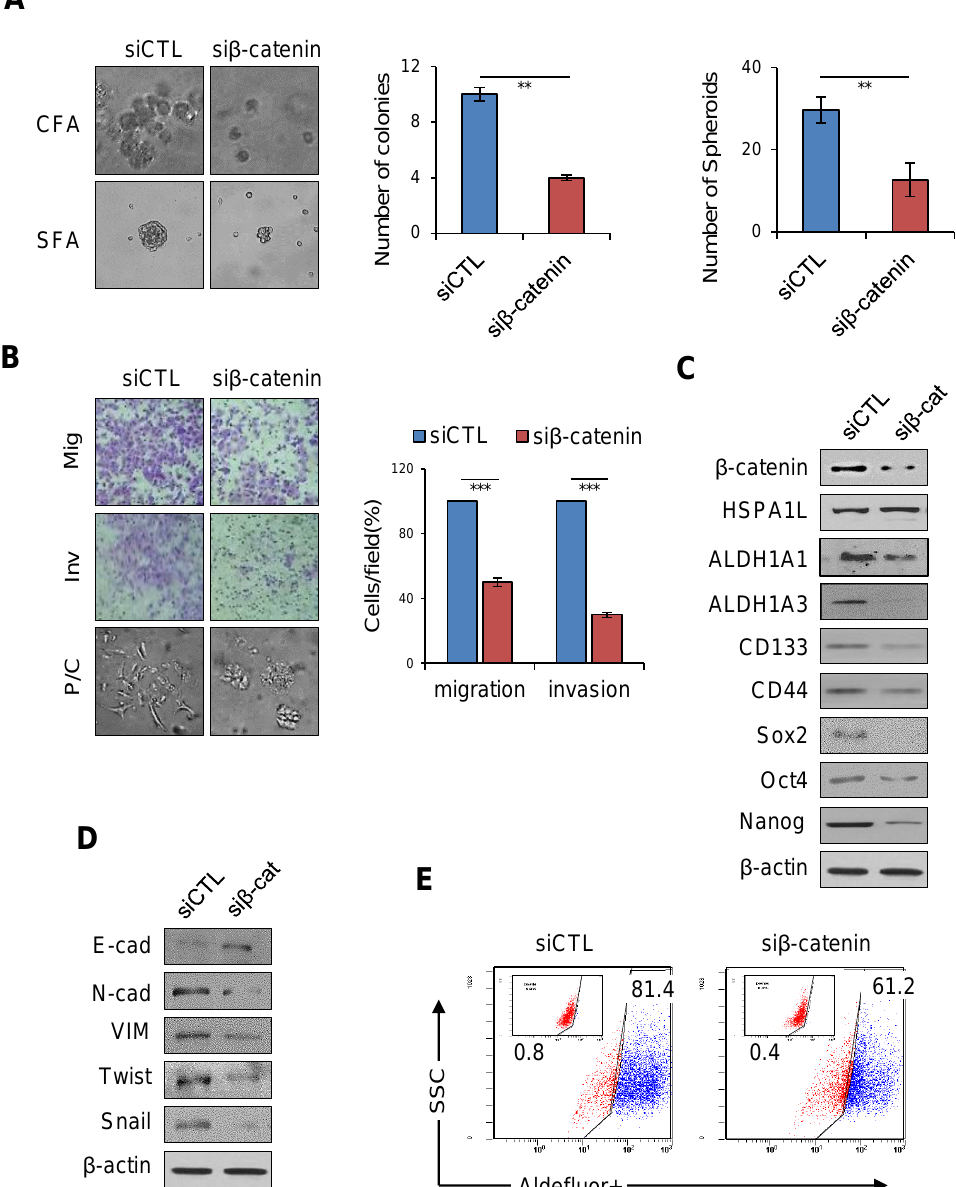
Figure 6. HSPA1L / β -catenin axis was involved in stemness by regulating ALDH1 expression. ( A ) Anchorage-independent colony and sphere formation of lung cancer in A549 cells transfected with siRNA targeting β -catenin. ( B ) Migration (upper panel), invasion (middle panel), and morphological (lower panel) assay in A549 cells transfected with siRNA targeting β -catenin. Cells were stained 72 h after transfection and photographed under phase-contrast microscopy. The stained cells were counted, and the relative number of cells per field was plotted. ( C ) Western blot analysis for CSC markers ALDH1A1, ALDH1A3, CD133, CD44, Sox2, Oct4, and Nanog in A549 cells transfected with siRNA targeting β -catenin. ( D ) Western blot analysis of EMT markers, E-cadherin, N-cadherin, Vimentin, Twist, and Snail in A549 cells transfected with siRNA targeting β -catenin. β -actin was used as a loading control. ( E ) FACS analysis in A549 cells transfected with siRNA targeting β -catenin. Data represent the mean ± SD of three independent experiments using a two-tailed t-test. ** p < 0.01, *** p <